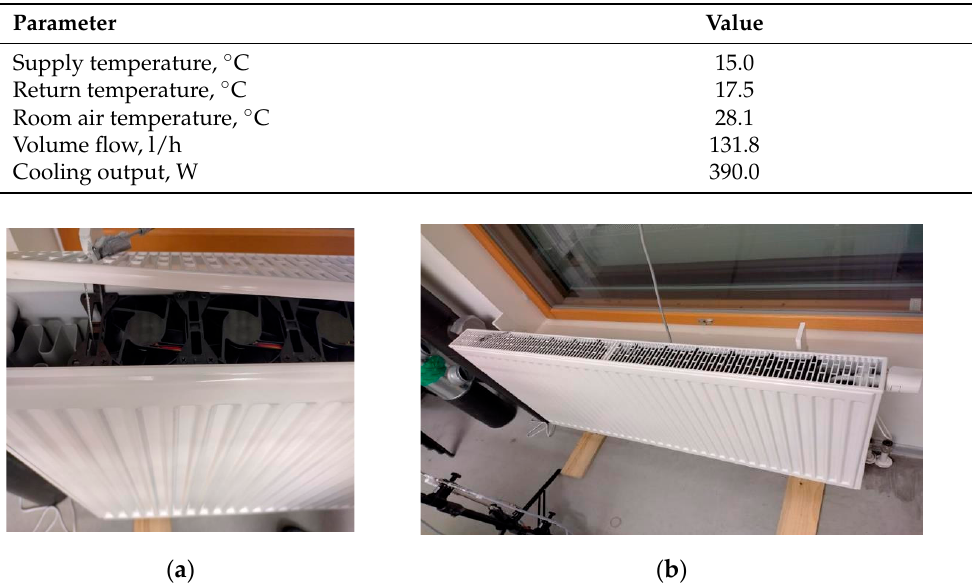
Table 3. Nominal operation parameters of the panel radiators.